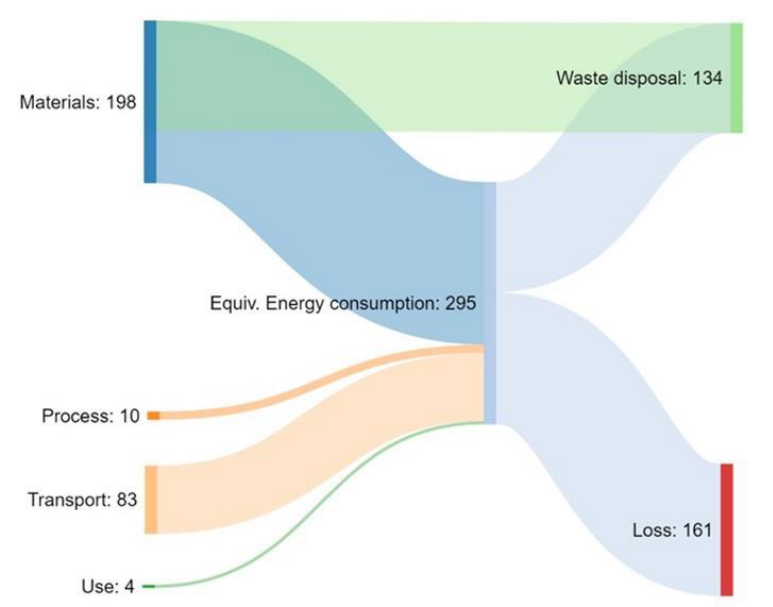
Figure 2. Energy flows needed and lost for 100 kg of greenhouse tomatoes (in MJ).